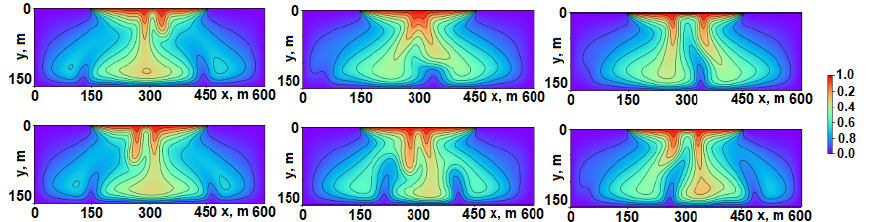
Figure 5. Asymmetric solutions at t > 15